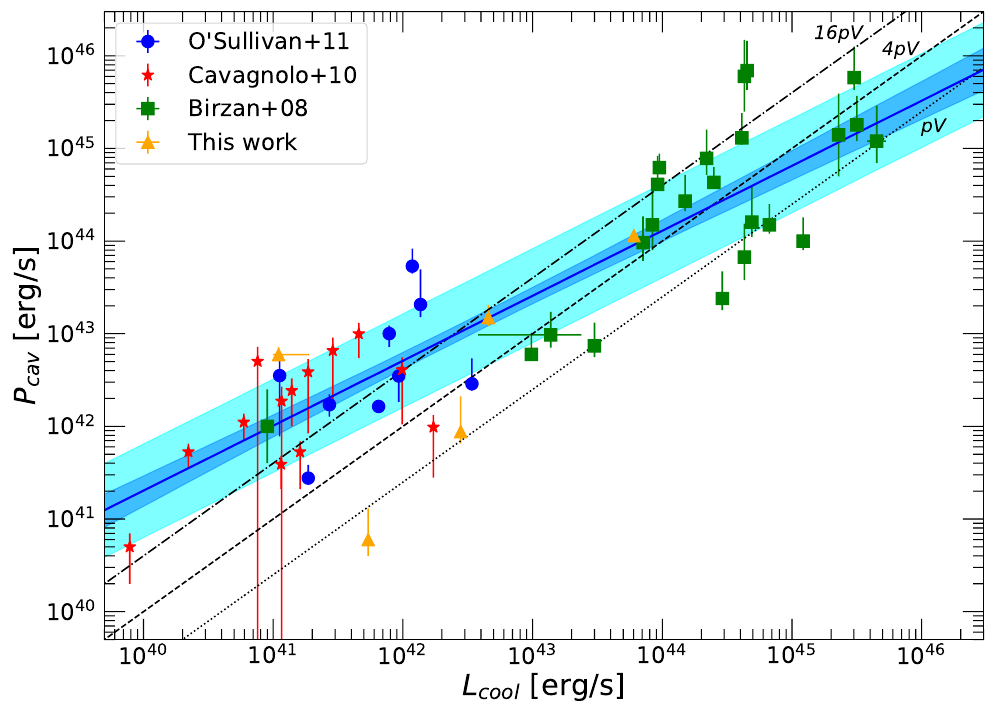
Figure 3. The relation between the luminosity within the cooling radius ( L cool ) and the power injected by the cavities assuming H = 4 pV ( P cav ) for several literature samples. The orange points were either recomputed for this work or collected from papers on individual objects; we refer to Table A1 for detailed references. The blue line shows a fit to the data using a power law with intrinsic scatter. The uncertainty on the fitted relation is indicated by the blue shaded area, whereas the cyan range indicates the intrinsic scatter around the